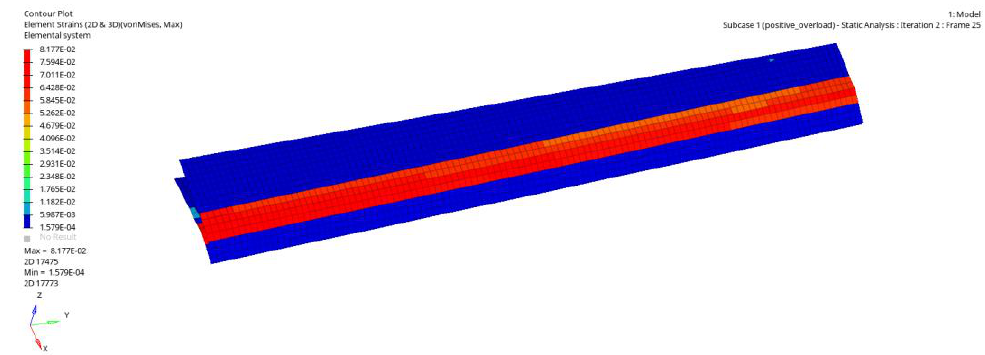
Figure 22. Strain of flexible skin (condition D).